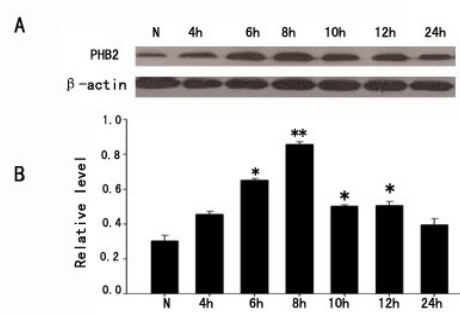
Figure 7. The expression change of PHB2 in H time courses of PHB2 expressions in PC12 cells after H confirm equal amounts of protein run on gel; ( B ) Quantification was made at each time point, the bar chart showed the ratio of PHB2 to β -actin at each time point; these data are means ± SEM. * p < 0.05, ** p < 0.01 ( n =